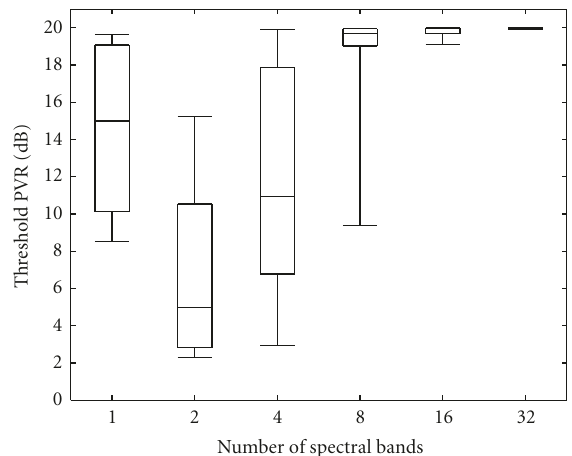
Figure 1: Results of the spectral discrimination test. Each box shows the median, quartiles, and 10th and 90th percentiles among the CI users for a specific stimulus type. The test and retest thresholds have been